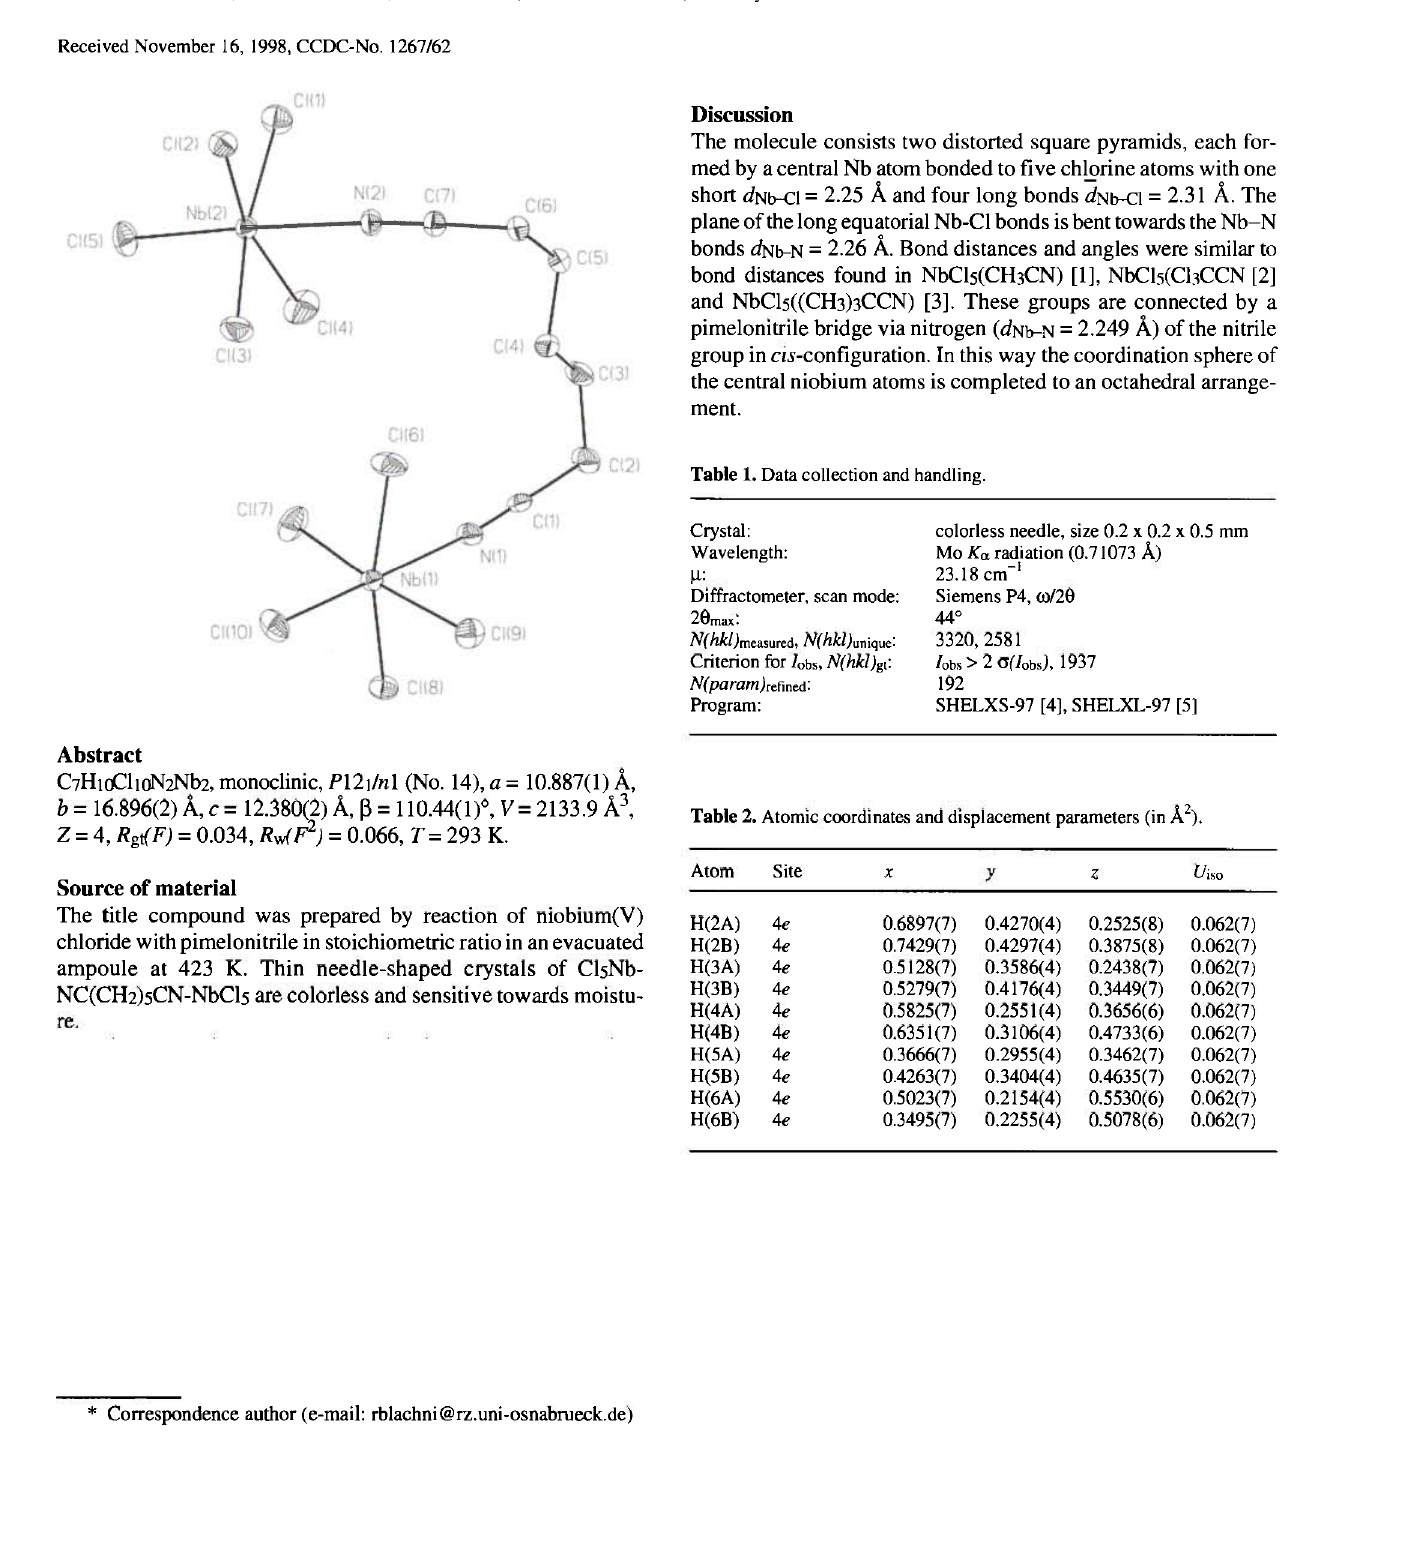
Table 1. Data collection and handling.